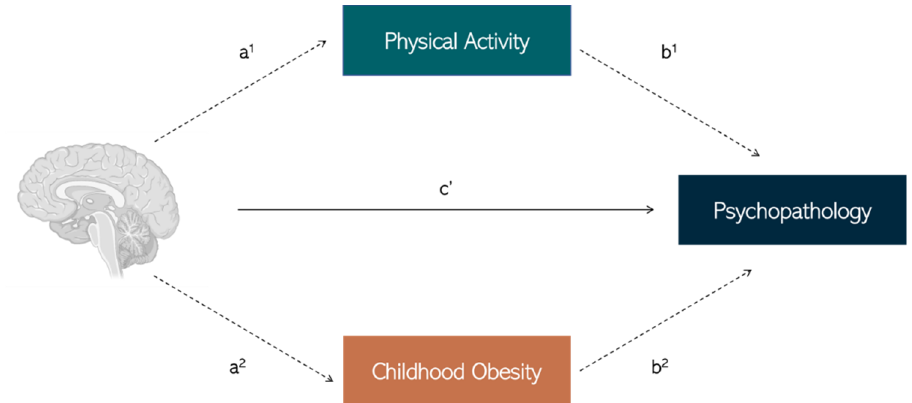
Figure 1. Hypothetical mediation model whereby the relationship between brain structure and function and psychopathology (c’ path) is mediated by protective factors such as physical activity (a 1 -b 1 path), and/or risk factors such as childhood obesity (a 2 -b 2 path). Created with BioRender.com [69], accessed on 25 October, 2022.